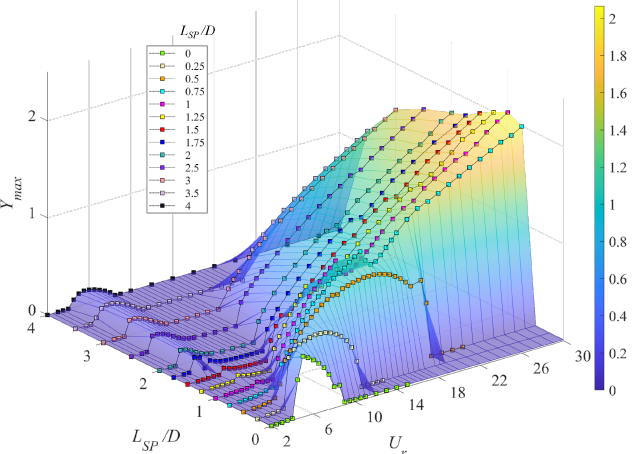
Figure 8. The normalized vibration amplitude plotted as a function of the plate length L SP and the reduced velocity U r .